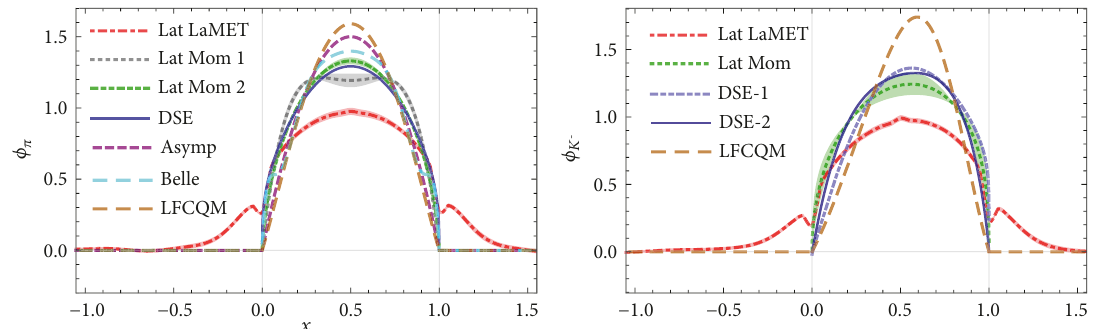
Figure 29: Improved pion (left) and kaon (right) DAs obtained in [224] employing the quasidistribution approach with 𝑃 3 ≈ 1.74 GeV (“LaMET”), together with models and parametrizations: from Dyson-Schwinger equation (“DSE”) [221], fit to Belle data (“Belle”) [222], parametrized fits to lattice moments (“Lat Mom”) [223], light-front constituent quark model (“LFCQM”) [225], and the asymptotic form (“Asymp”). Source: [224] (arXiv), reprinted with permission by the Authors.